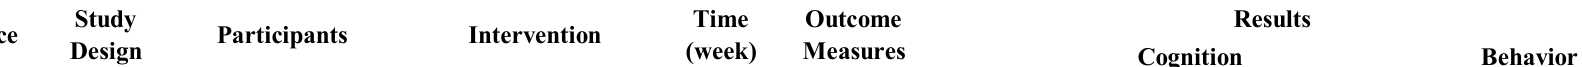
Table 2. Clinical trials of DHA supplementation on outcomes of cognition and behavior in